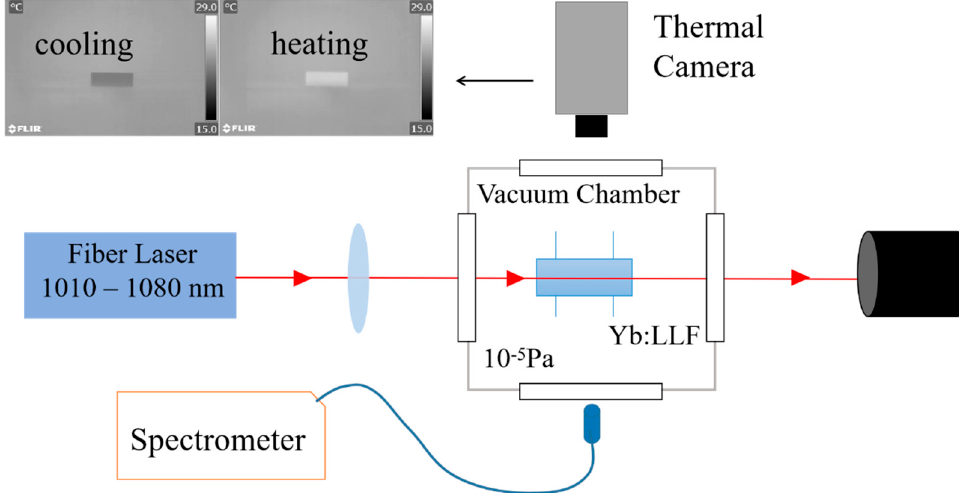
Figure 1. The schematic of the LITMoS test set-up.